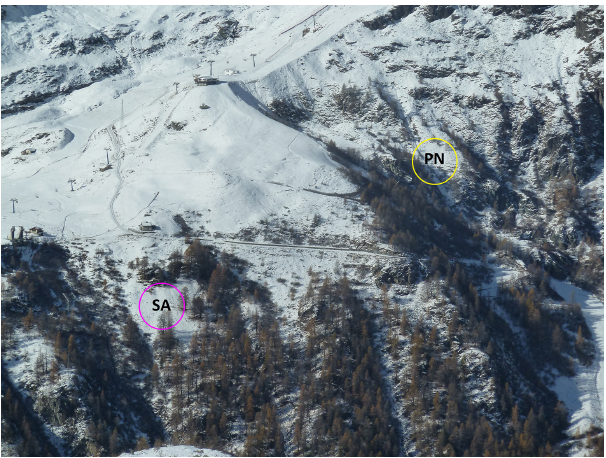
Figure 2. Winter view of the study area: in the circles the location of the two test sites Pista Nera (PN) and Sant’Anna (SA) is shown.